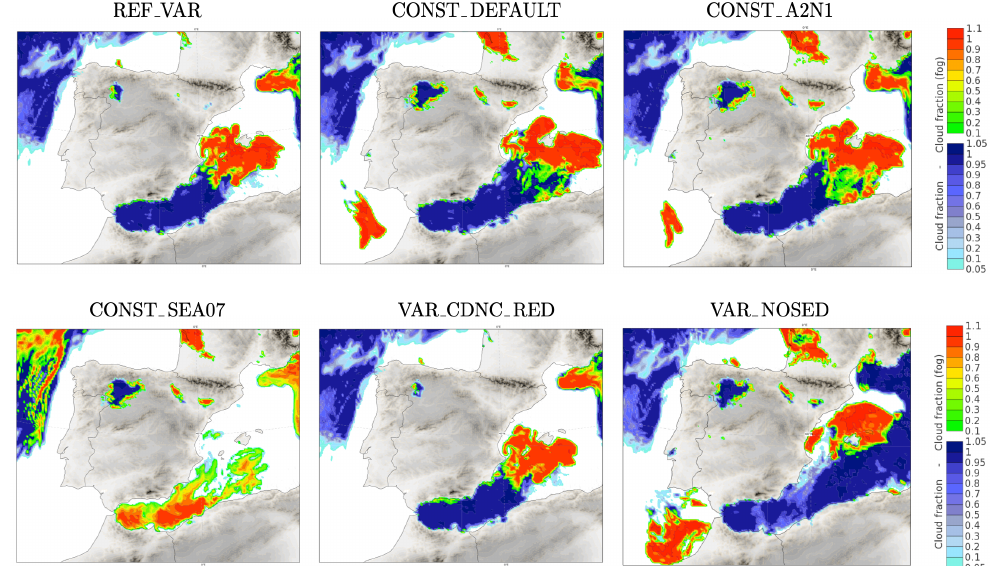
Figure 8. Iberian domain. Fraction of low clouds and fog (cloud fraction at the lowest model level), +047 h (31 December 2021 at 11 UTC). The two colour bars to the right side of the panels correspond to fog (upper colour bar; from green to red) and low clouds (lower colour bar; from cyan to dark